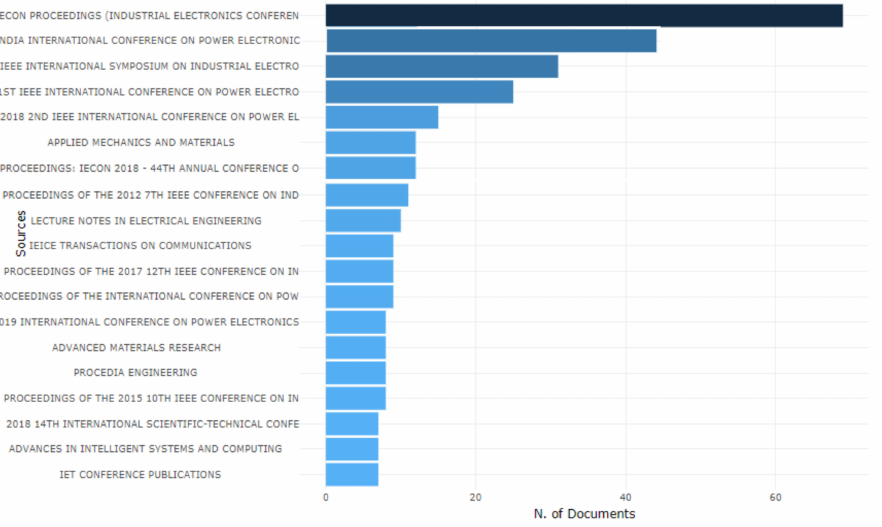
Figure 16. Most relevant sources according to